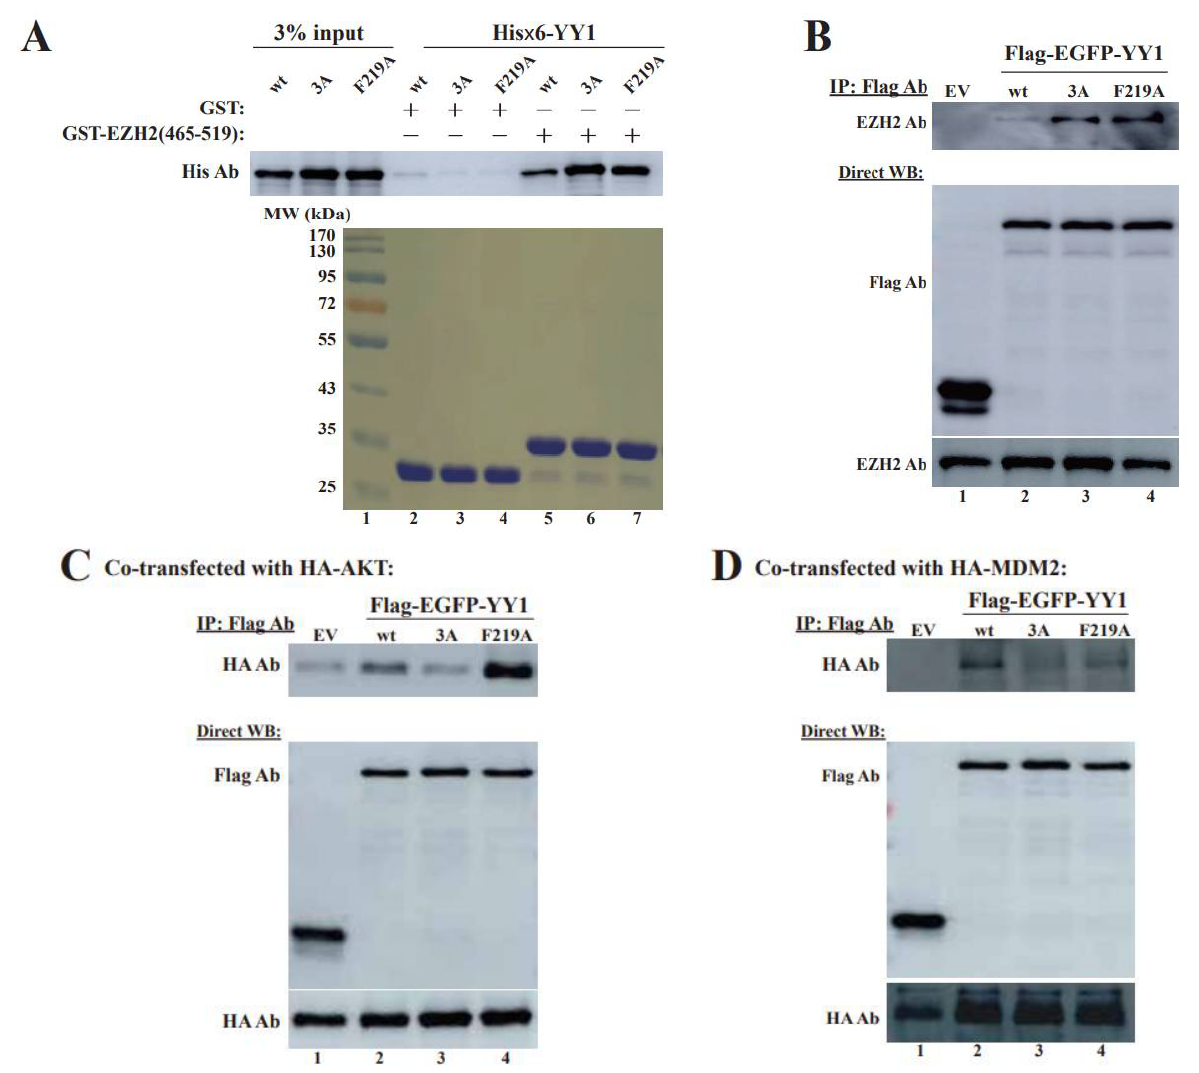
Figure 5. Evaluation of the effects of OPB mutations on YY1 interaction with oncoproteins. ( A , B ) Examination of the interaction between YY1 OPB mutants and EZH2. In A, GST and GST- EZH2(465–519) were individually incubated with purified His × 6-YY1 wt, 3A and F219A mutants, followed by extensive wash and Western blot analyses using a His-tag antibody. The input of GST and GST-EZH2(465–519) is shown at the lower panel. In ( B ), plasmids of Flag-EGFP-YY1 wt, 3A and F219A were individually transfected into HeLa cells, followed by IP using the Flag antibody and Western blot analyses using an EZH2 antibody. Direct Western blot analyses were conducted using the antibodies as labeled. ( C , D ) Examination of the interaction of YY1 OPB mutants with AKT and MDM2. Flag-EGFP-YY1 plasmid was cotransfected with HA-AKT ( C ) or HA-MDM2 ( D ) into HeLa cells, followed by IP using the Flag antibody and Western blot analyses using an HA antibody. Direct Western blot analyses were conducted using the antibodies as labeled. Original images of all Western blot data are available in File S1